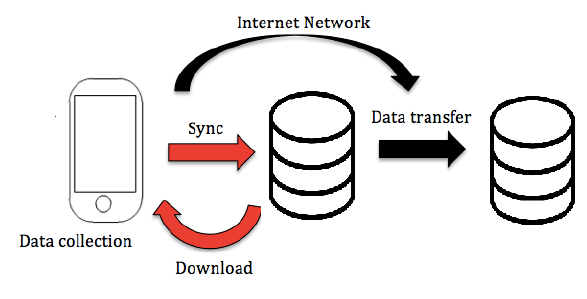
Figure 1. Data framework of the